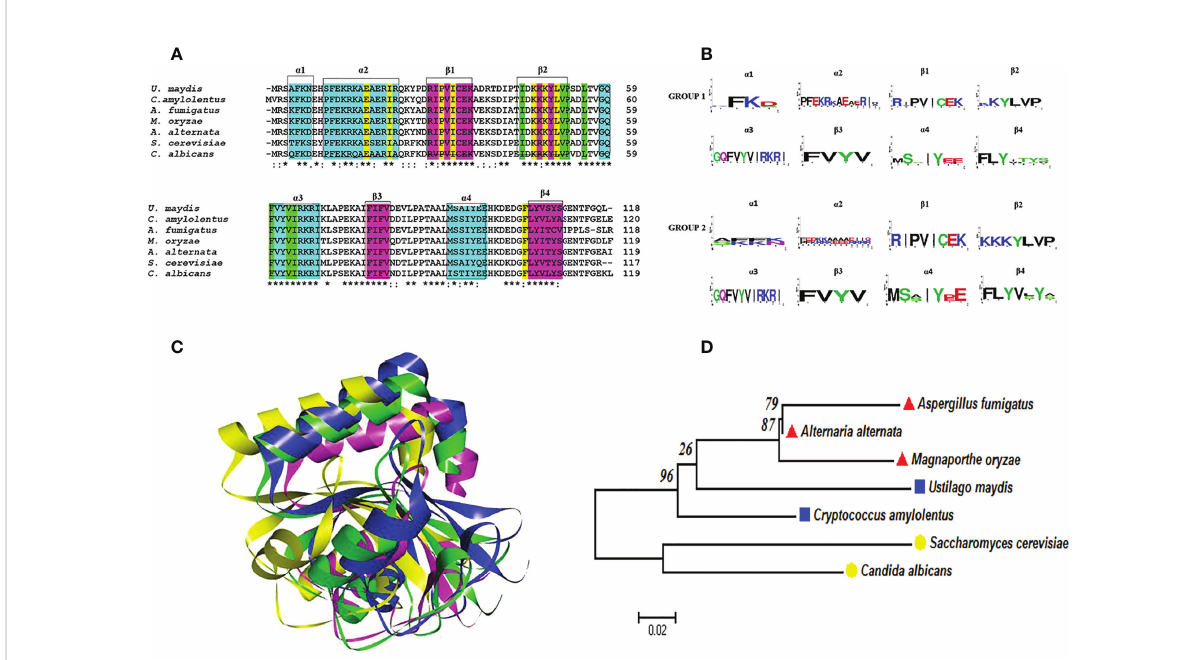
FIGURE 4 Atg8 proteins are conserved in pathogenic and nonpathogenic fungi. (A) Multiple alignments were performed with Clustal Omega. In the alignment, the amino acids associated with alpha-helical (cyan) or beta-strand (fuchsia) secondary structures are highlighted with boxes. Likewise, the important amino acid residues for the two deep hydrophobic pockets HP1 and HP2 function are highlighted in yellow and green, respectively. An asterisk (*) denotes a completely conserved residue; a colon (:) represents the conservation of the properties of the residual